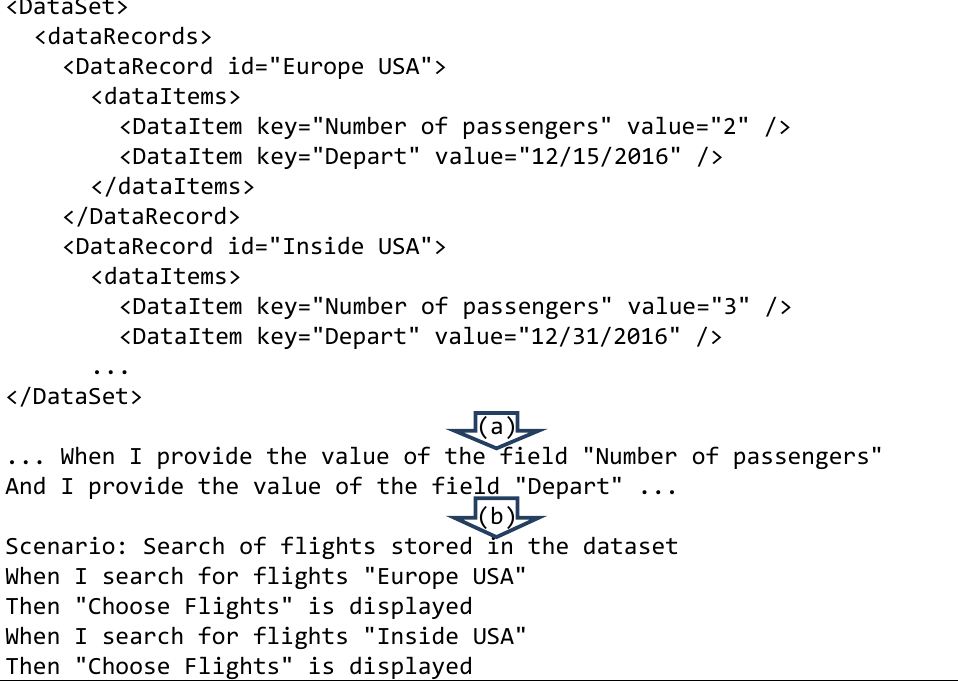
Figure 30. Data stored in an XML file: (a) data associated to XML file, (b) reference to